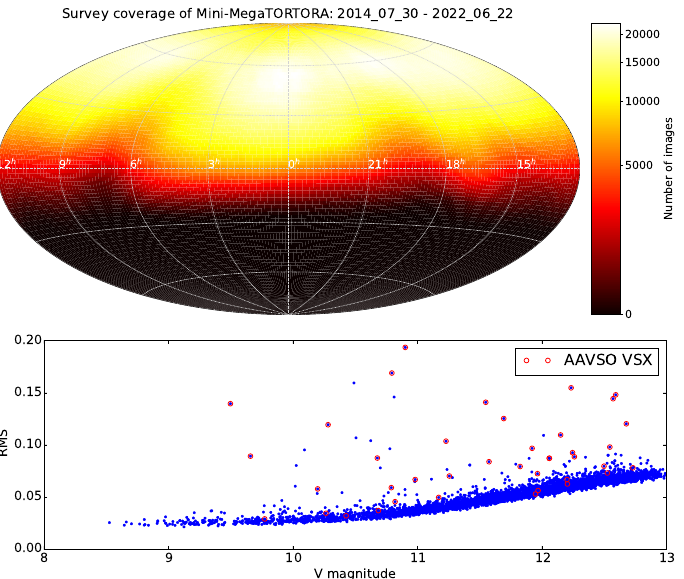
Figure 8. Top panel : the sky coverage of the Mini-MegaTORTORA Sky Survey, i.e., the number of survey frames covering a given position in the sky. Bottom panel : a typical RMS along the light curves in the survey data as a function of mean magnitude. The red circles mark the known variable stars from the AAVSO VSX